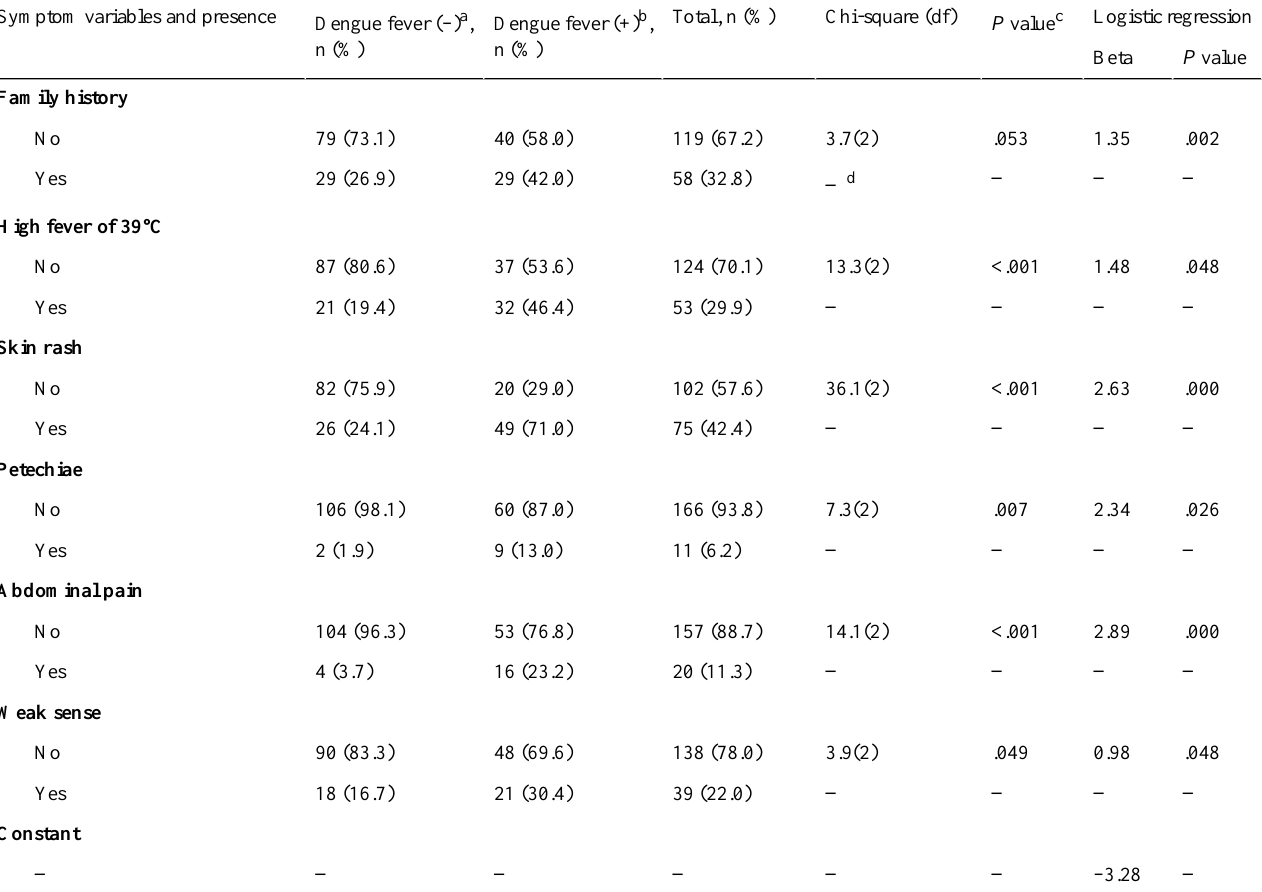
Table 2. Logistic analysis of symptoms for the patients suspected with dengue virus infection using the univariate